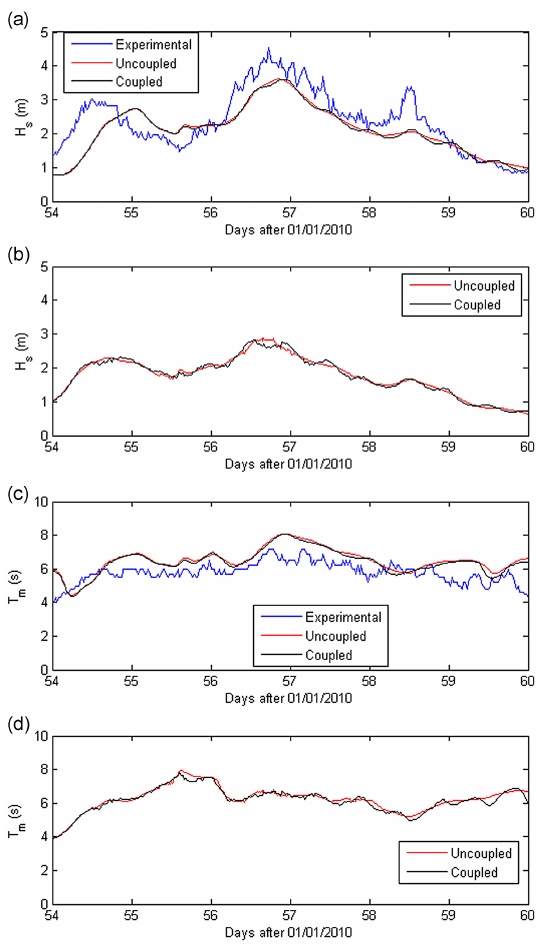
Figure 8. Wave conditions during the 25–26 February 2010 storm: (a) comparison between coupled and uncoupled modelled H s (m) with observed data in Firth of Forth wave gauge; (b) comparison between coupled and uncoupled modelled H s (m) in the Aberdeen wave gauge; no observation data were available from this wave gauge during this storm; (c) comparison between coupled and un- coupled modelled T m (s) with observed data in Firth of Forth wave gauge; (d) comparison between coupled and uncoupled modelled T m (s) in the Aberdeen wave gauge, no observed data were avail- able from this wave gauge during this storm.